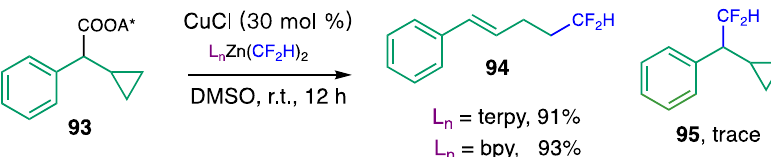
Fig. 6 Mechanistic studies. a Dimerization of the relayed radical with bpy as the ligand. b Effect of ligands on the decarboxylative di fl uoromethylation reactions. c Radical clock experiments. terpy, 2,2 ʹ ;6 ʹ ,2 ʹʹ -terpyridine; bpy, 2,2 ʹ -bipyridine; DMSO, dimethyl